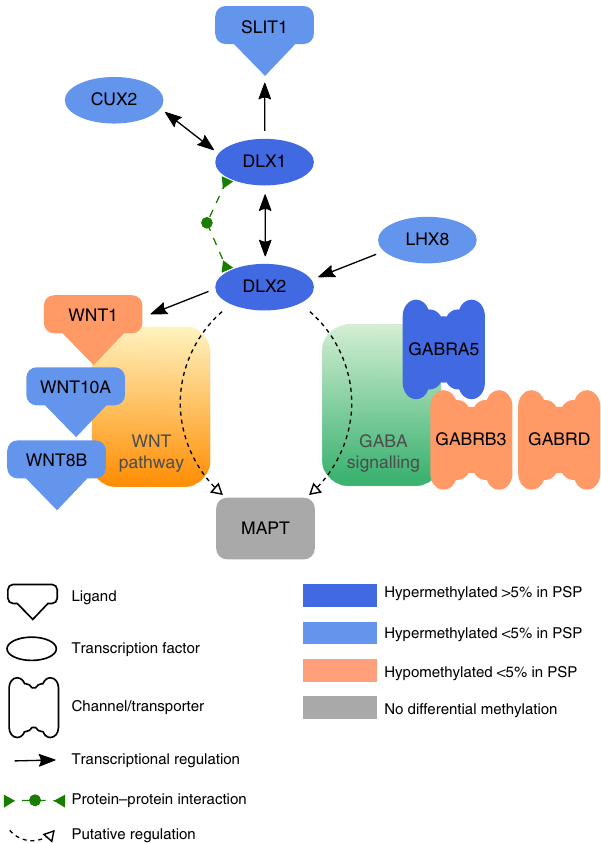
Fig. 6 Pathway analysis. The pathway proposed was deduced from in silico literature mining for functional interactions of the differentially methylated genes. The network was consolidated by veri fi cation of each interaction in the published literature. Hypermethylated genes are depicted in blue and hypomethylated genes are given in orange. Note that DLX1/DLX2 may in fl uence MAPT either via the WNT (brown) or via the GABA signaling (green) pathway (for details see